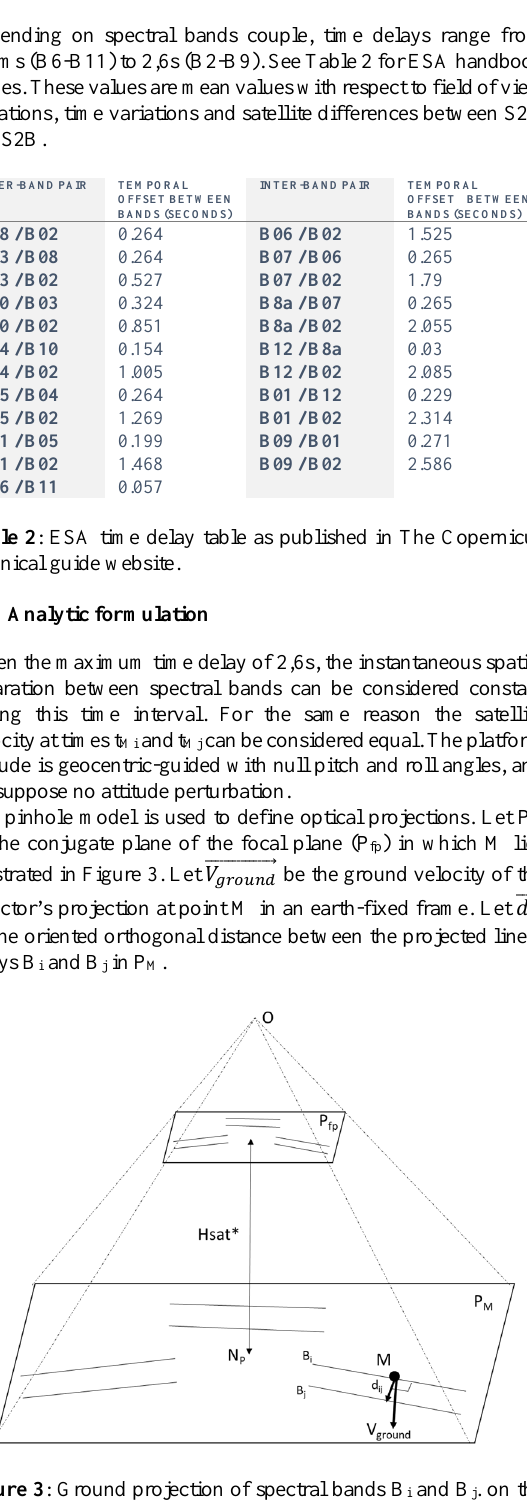
Figure 3 : Ground projection of spectral bands B i and B j . on the conjugate plane P M and definition of d ij .